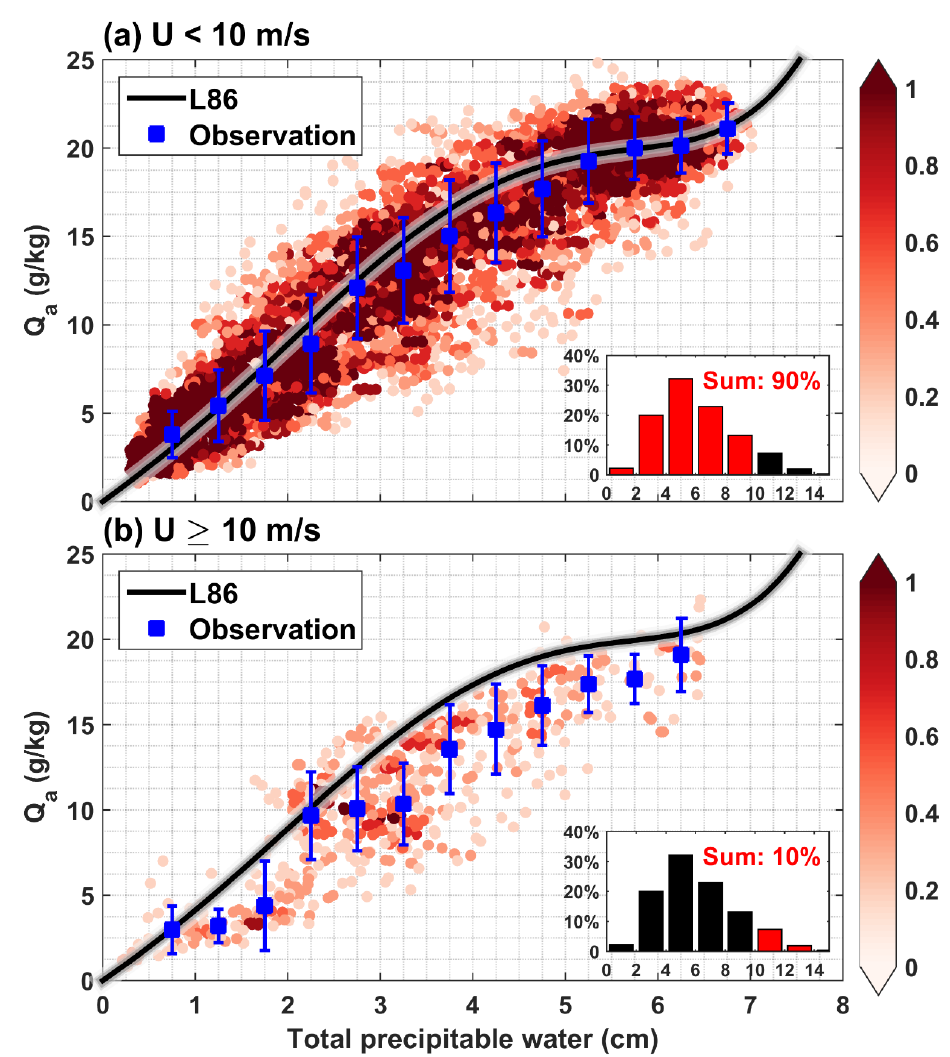
Figure 8. The same as Figure 7 but for two conditions of U .